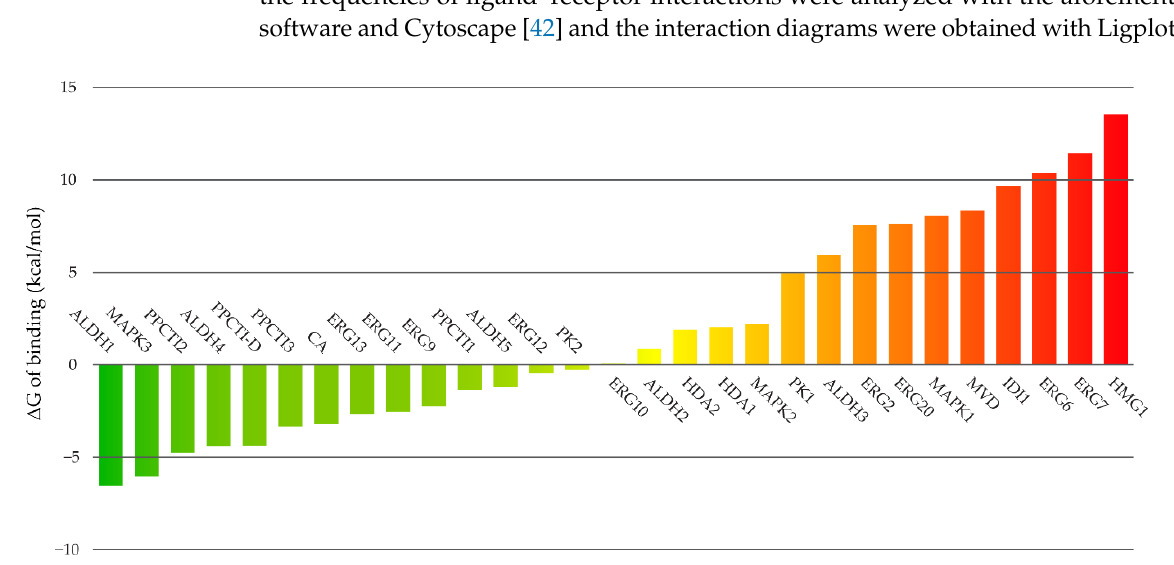
Figure 1. Predicted free energies of binding of compound 16 to its potential targets.